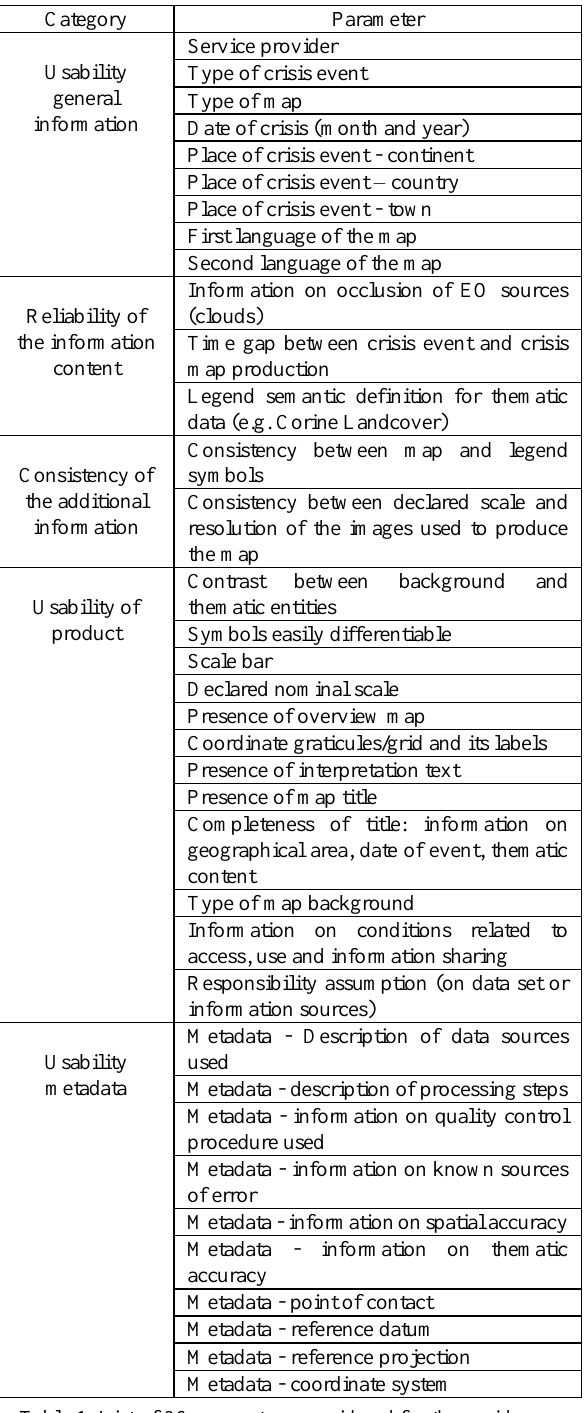
Table 1. List of 36 parameters considered for the rapid map quality